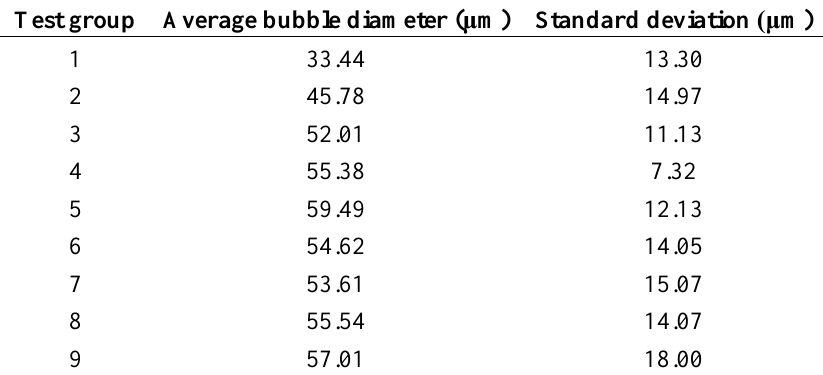
Table 2. Average MNBs size of different test groups.